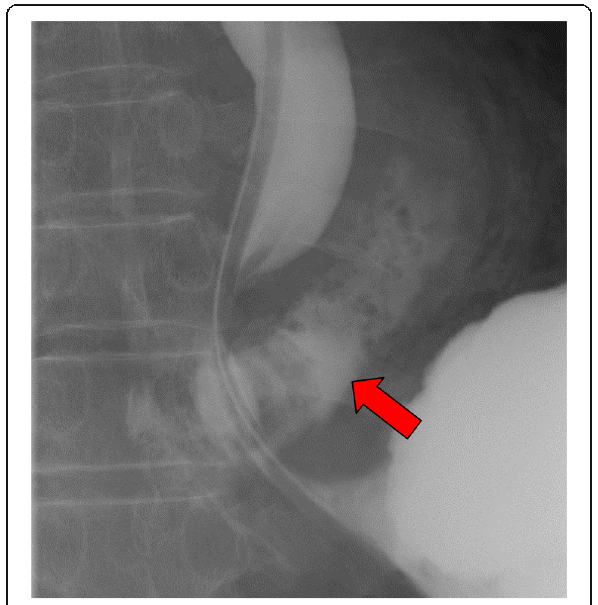
Fig. 2 Contrast study. Red arrow shows the extravasation of contrast